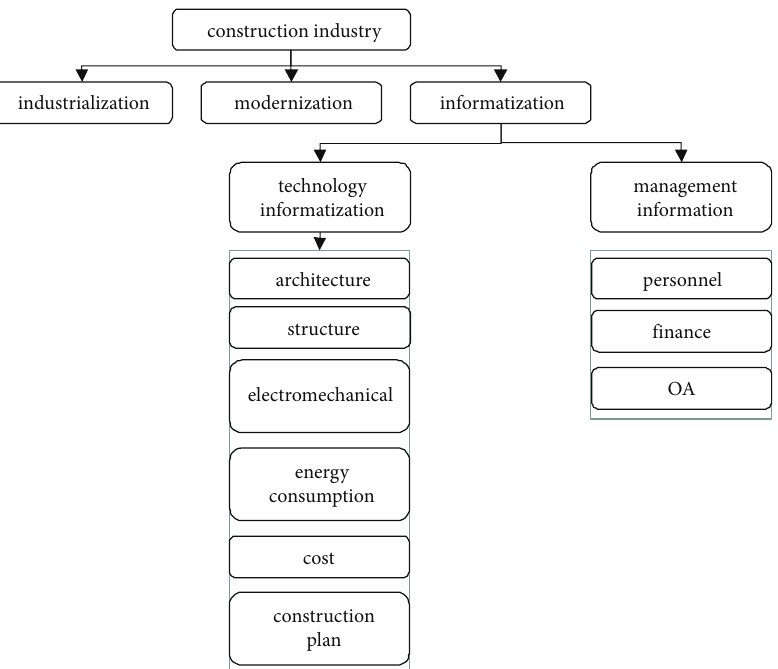
Figure 2: Status quo of informatization application in construction